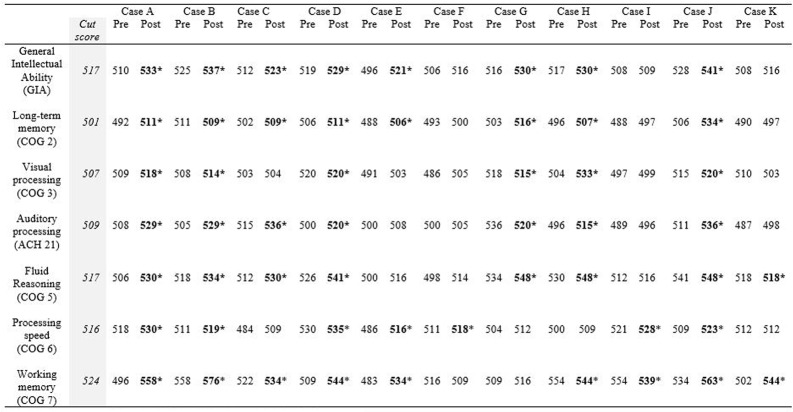
Cut score thresholds and clinically significant change.∗Post-test scores meeting threshold for clinically significant change are in bold.